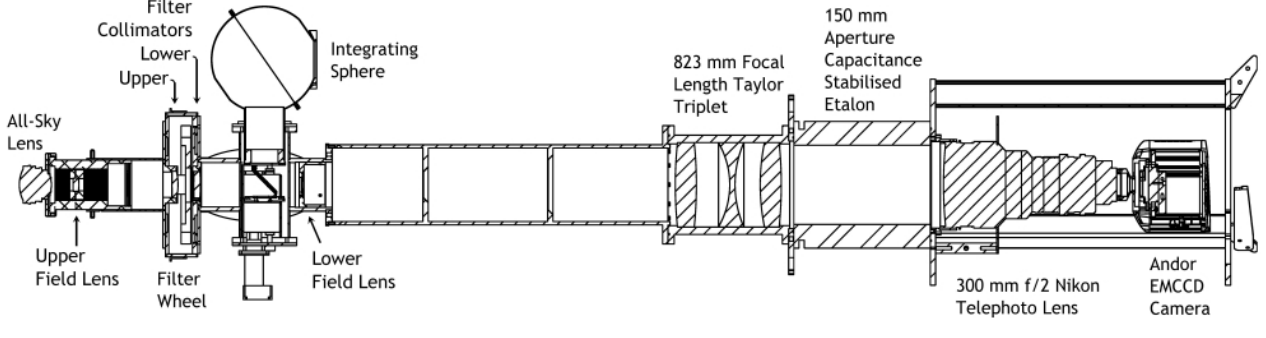
Fig. 1. Schematic of the Mawson all-sky imaging Fabry-Perot spectrometer.